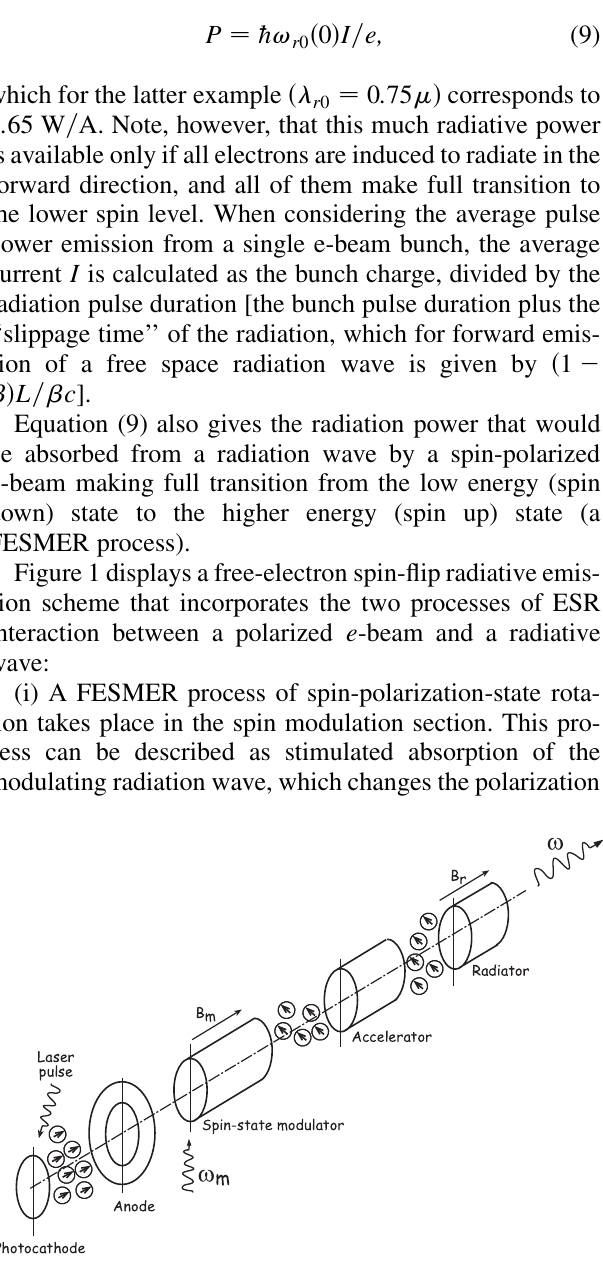
FIG. 1. A scheme for electron spin-state rotation (FESMER) and radiation